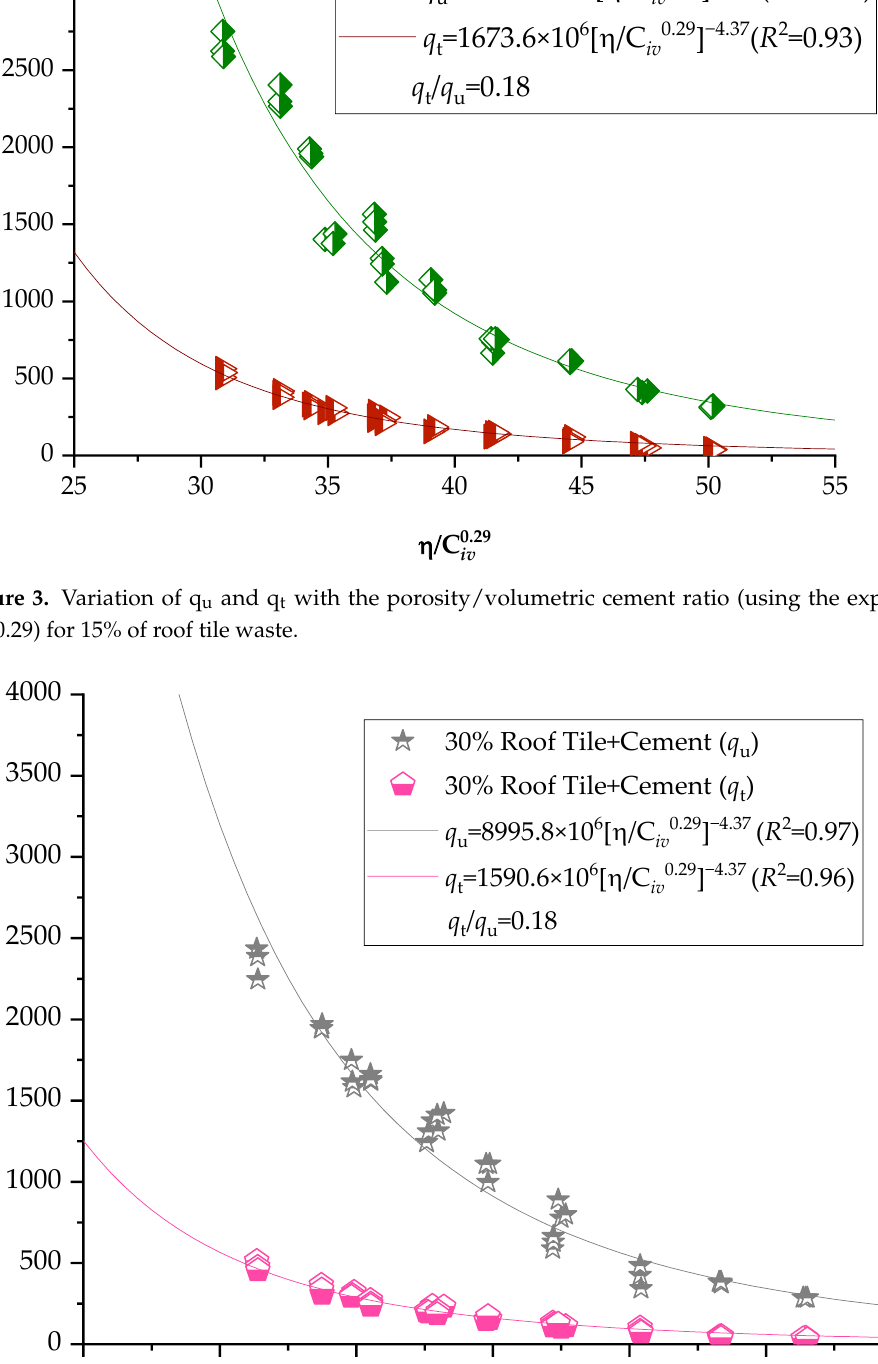
( b ) Figure 5 . ( a ) Influence of cement percentages on the q u for 15% roof tile waste; and ( b ) Influence of the porosity on the q u for 15% roof tile waste . 4.2. Empirical Relationships between q u and q t For each RT (in %), an empirical relationship between tensile/compression can be calculated as a function of η/C iv directly. As the equations 𝑞 𝑢 ∨ 𝑞 𝑡 = 𝐴 𝑞 [η/𝐶 𝑖𝑣𝑏 ] −𝑘 have the same format (with a difference in the constants A q , which can be divided into A qu for com- pression and A qt for tensile), when dividing 𝐴 𝑞𝑡 [η/𝐶 𝑖𝑣𝑏 ] −𝑘 and 𝐴 𝑞𝑢 [η/𝐶 𝑖𝑣𝑏 ] −𝑘 , a constant is